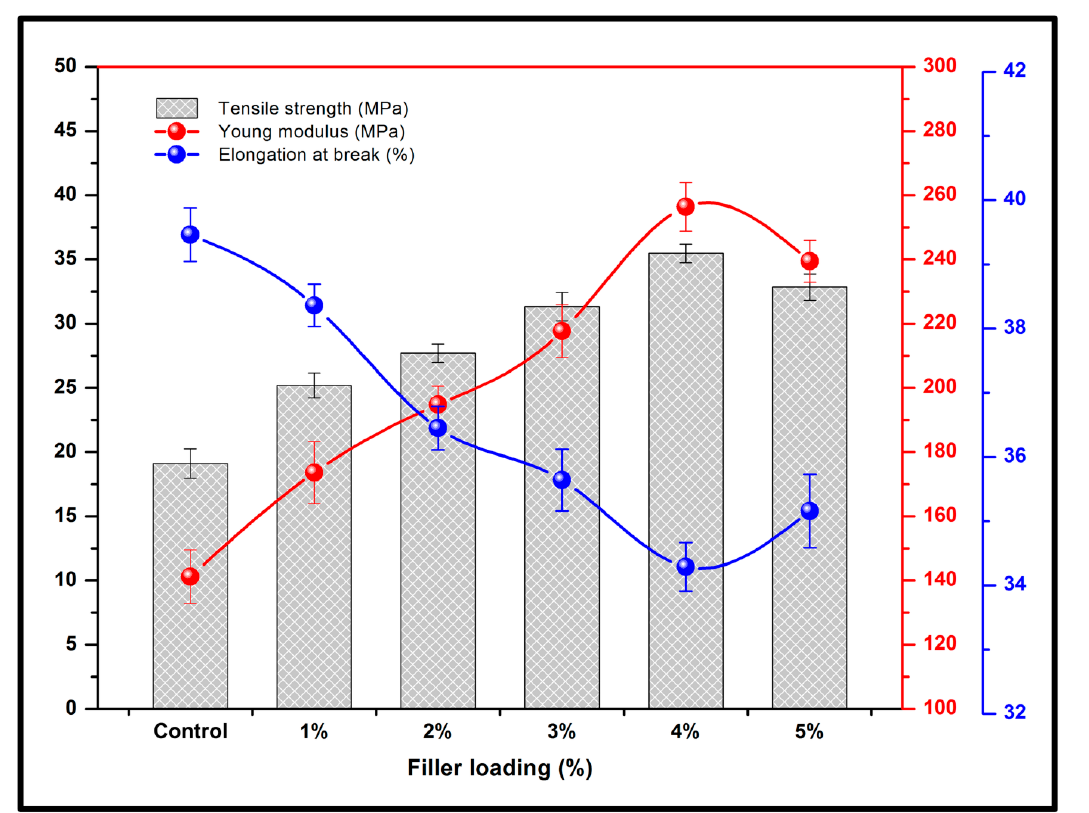
Figure 7. Tensile properties of the fabricated seaweed/coffee biopolymer film.